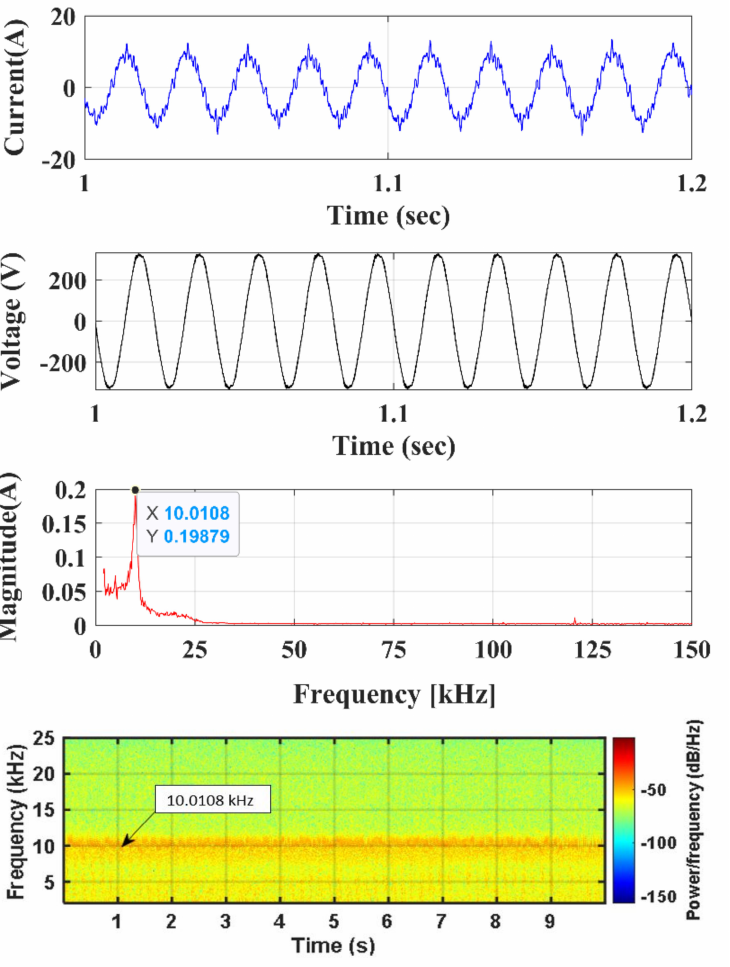
Figure 8. Transformer MV side current and voltage waveforms along with its spectrum with domi- nant emission at 10 kHz at PCC of wind turbines of feeder